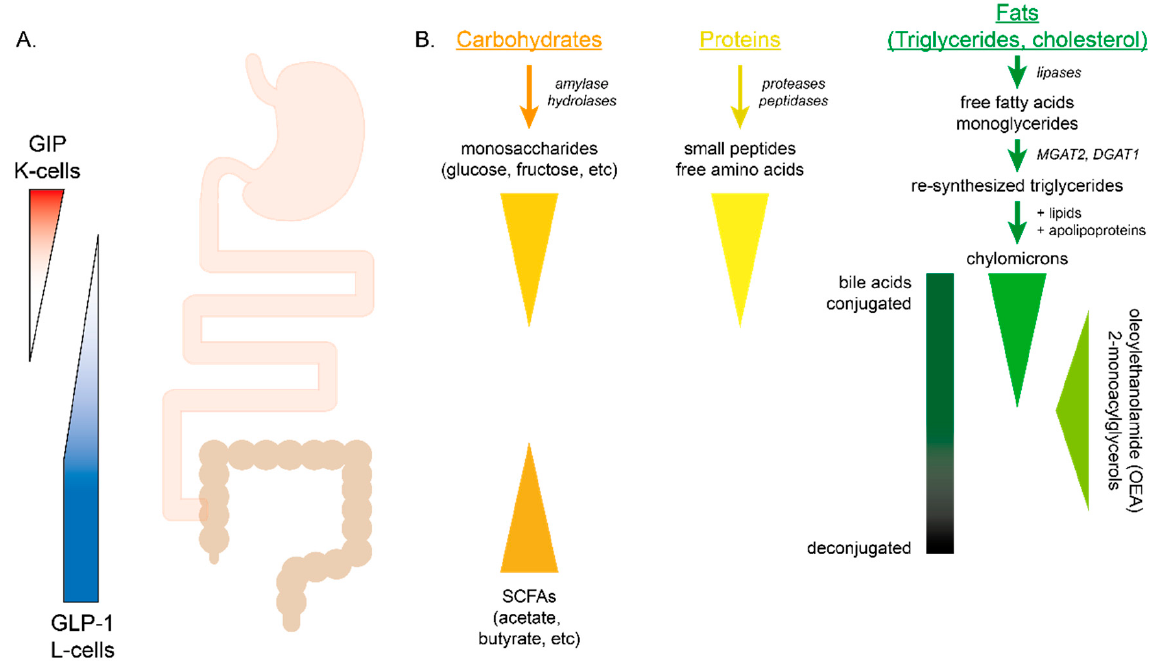
Figure 1. Overview of macronutrient digestion. ( A ) Schematic representation of the distribution of glucose-dependent insulinotropic polypeptide (GIP) expressing K-cells and glucagon-like peptide 1 (GLP-1) expressing L-cells along the longitudinal intestinal axis. ( B ) Schematic representation of major sites of macronutrient digestion and absorption for carbohydrates, proteins and fats along the longitudinal intestinal axis. The breakdown of macronutrients denoted above primary location of nutrient absorption. Whereas absorbed monosaccharides and amino acids are exported from the intestinal epithelium as such, the majority of free fatty acids and monoglycerides are stepwise re-synthesised within the epithelium by MGAT2 and DGAT1 into triglycerides, which together with other lipophilic substances are secreted as chylomicrons. The production of lipid metabolites, such as OEA and 2-monoacylglycerides, which are synthesized following absorption of dietary fats, is represented in light green. Conjugated bile acids released following fat detection in the proximal small intestine is deconjugated in the distal intestine by colonic gut bacteria, as indicated by a dark green bar. Few macronutrients escape absorption in the small intestine, but bacterial fermentation of “indigestible fibres” provides SCFA as another nutritional source in the large intestine. Abbreviations: DGAT1, diacylglyceride-acyltransferase-1; GIP, glucose- dependent insulinotropic polypeptide; GLP-1, glucagon-like peptide 1; MGAT2, monoacylglyceride-acyltransferase-2; OEA, oleoylethanolamide; SCFAs, short-chain fatty acids.